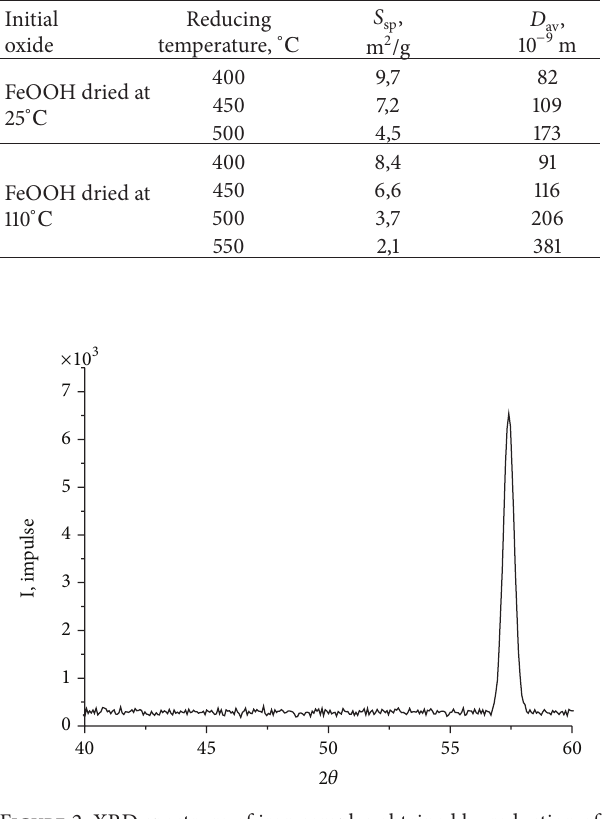
Figure 2: XRD spectrum of iron samples obtained by reduction of sample 2 in hydrogen flow at 400 ∘